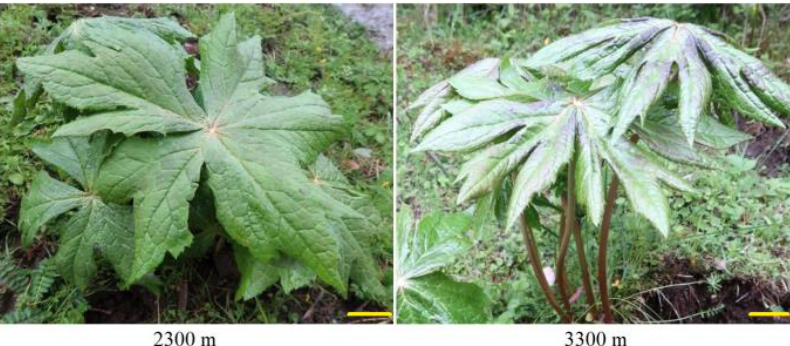
Figure 7. Aerial parts of 3-year-old S. hexandrum plants grown at 2300 and 3300 m. Bar represents 2 cm.